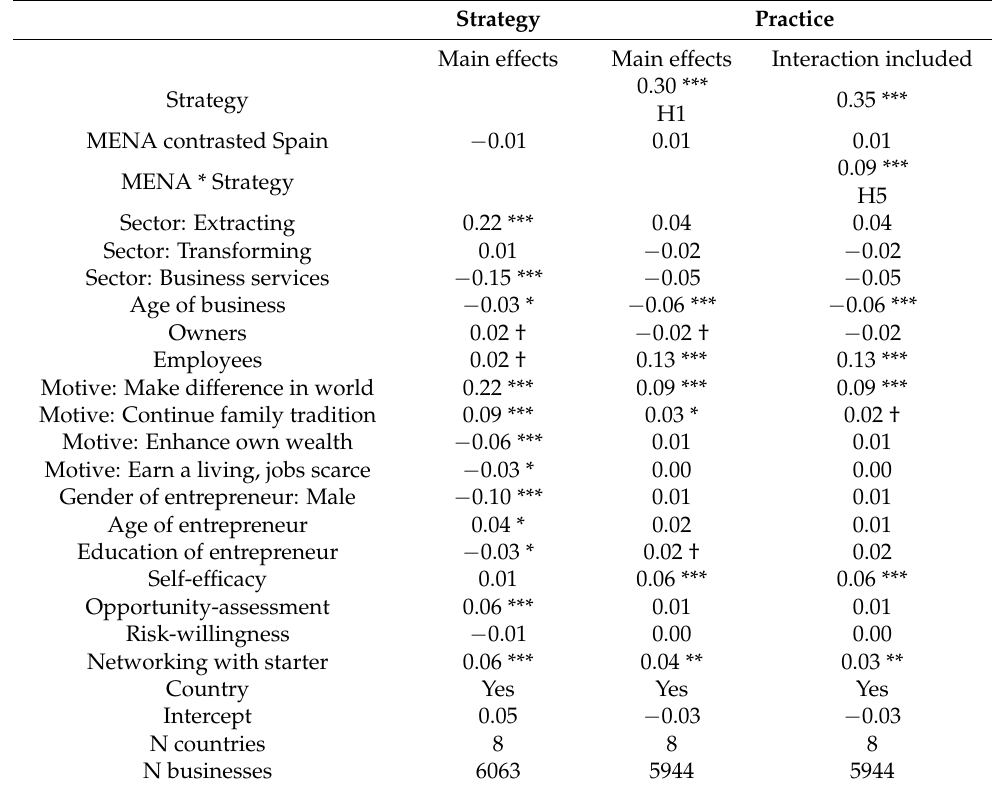
Table 10. Strategy and practice in businesses, affected by characteristics of businesses and en- trepreneurs; MENA and Spain. Strategy Practice Main effects Main